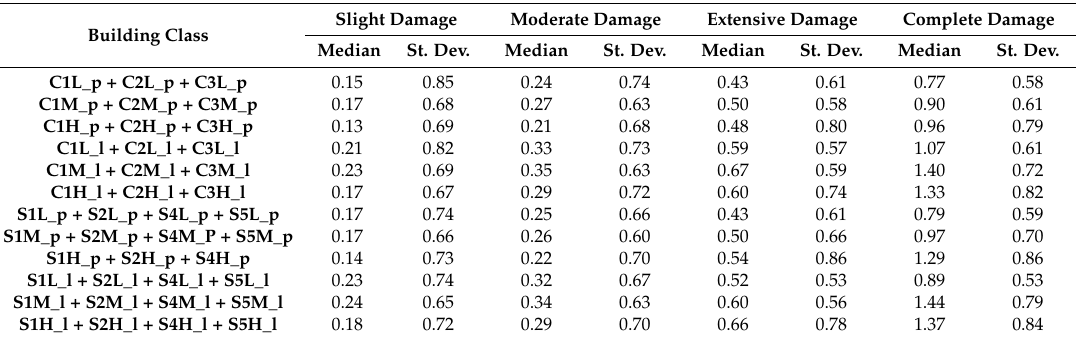
Table A2. Median and standard deviation for simplified reinforced concrete (C) and simplified steel buildings (S) for short strong motion duration (M ≤ 5.5).